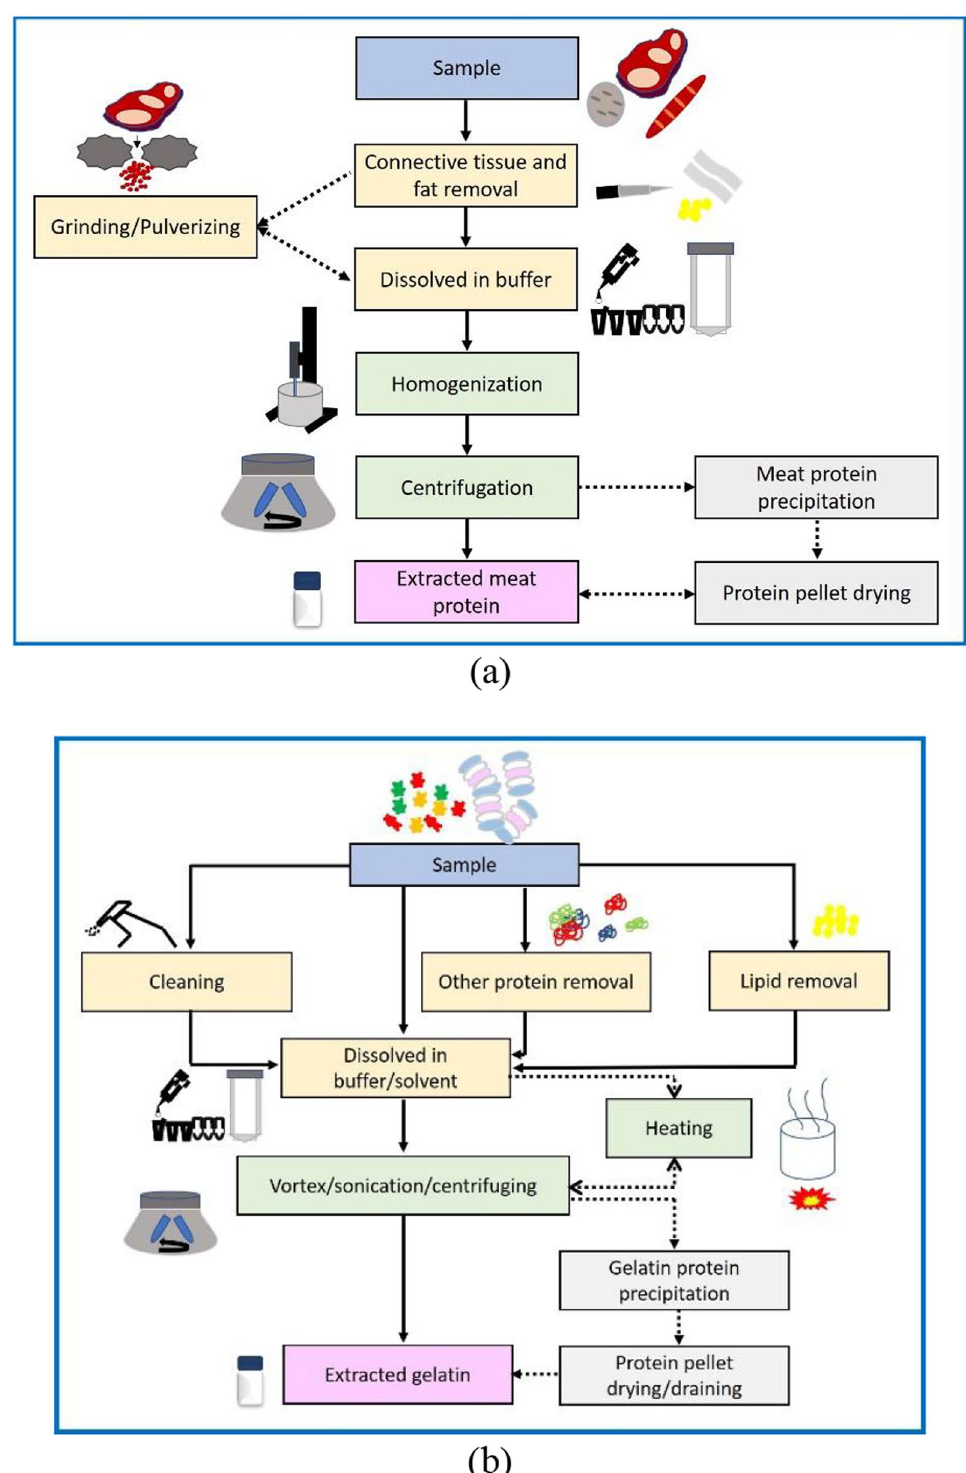
Fig. 2 General workflow of porcine protein extraction of a meat-based food and b gelatin-based food prior to the LC–MS